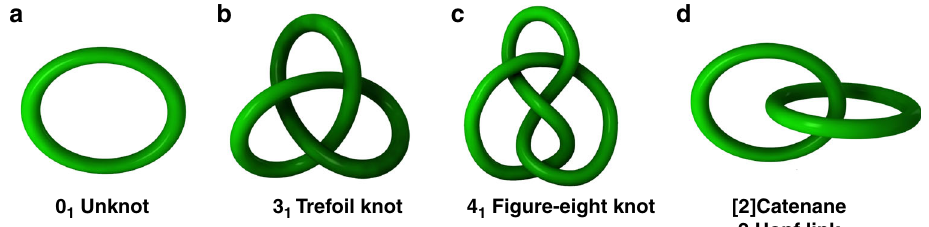
Fig. 1 The macrocycles, molecular knots and links prepared in this study with their trivial names and descriptors using the Alexander – Briggs notation 38 . a 0 1 Unknot, ( b ) 3 1 Trefoil knot ( c ) 4 1 Figure-eight knot and ( d )